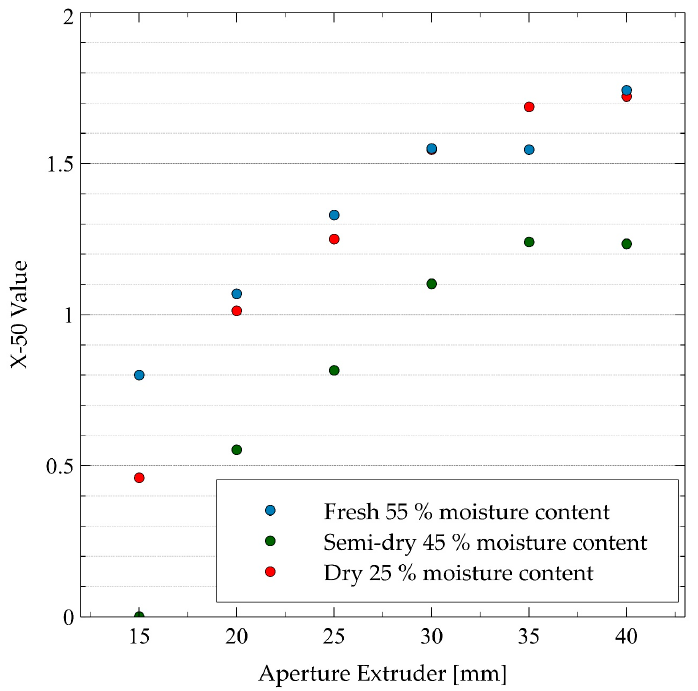
Figure 7. Average particle size (X-50 value) of poplar fibres with dependence on aperture setting during extrusion.